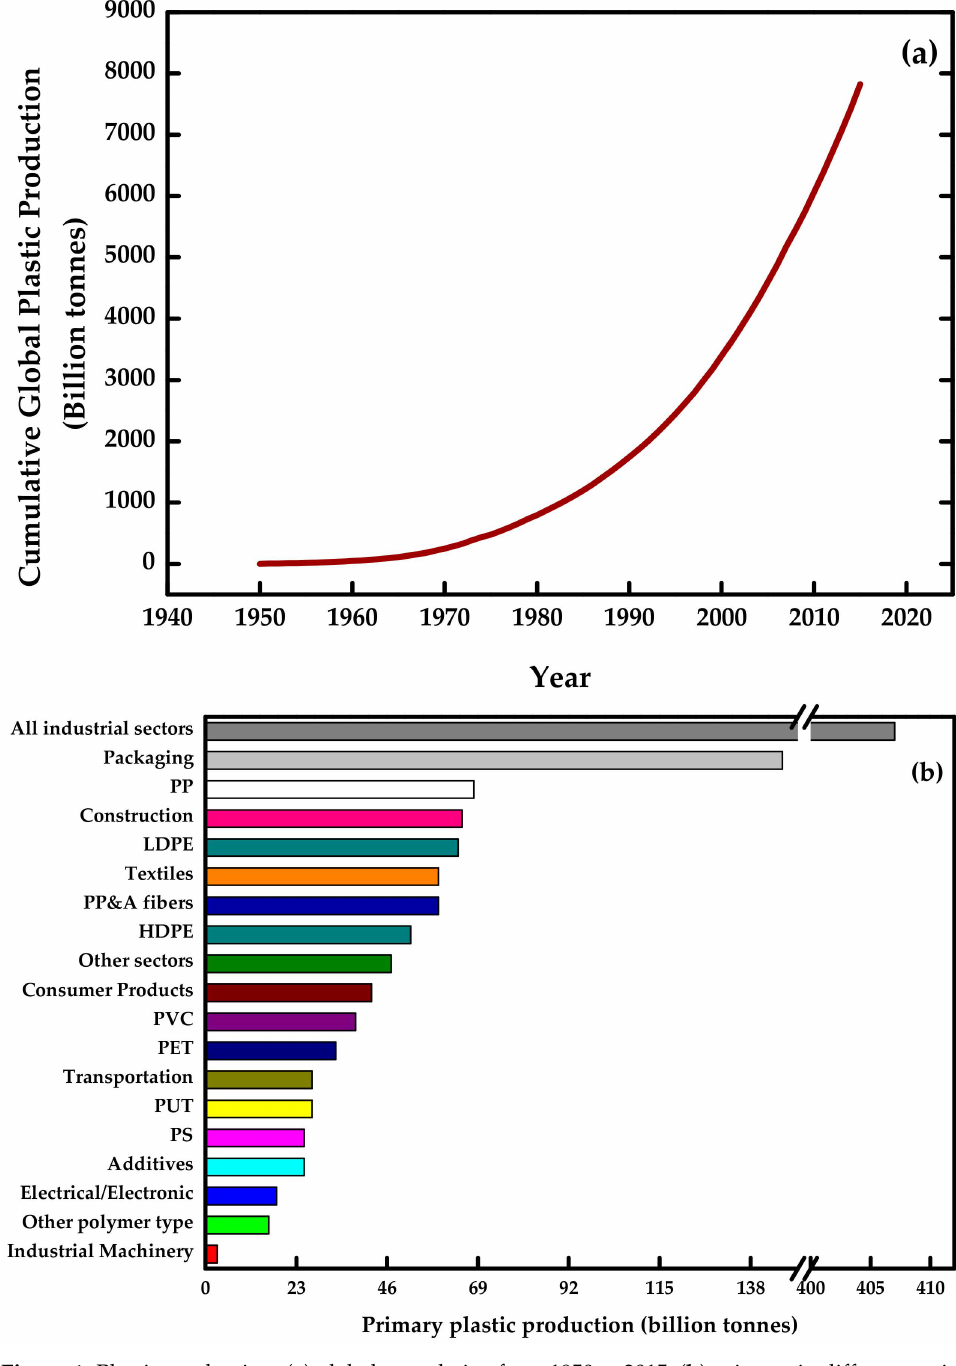
Figure 1. Plastic production: ( a ) global cumulative from 1950 to 2015, ( b ) primary in different entities at 2015. Prepared from data in